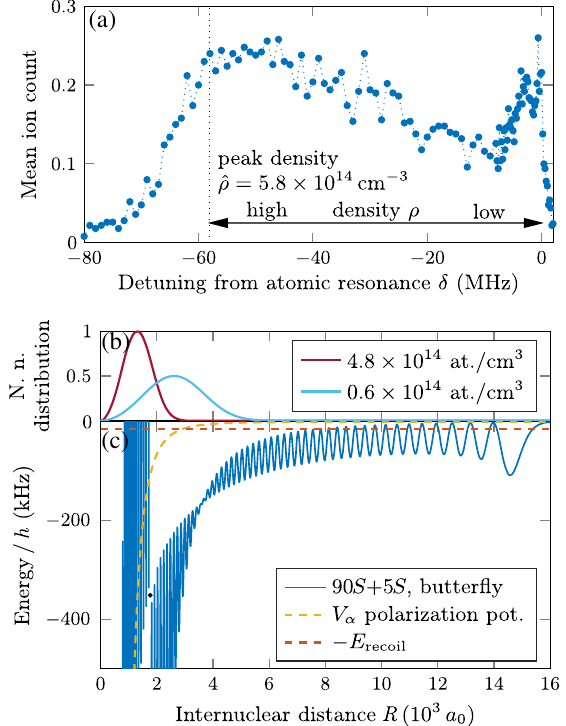
FIG. 2. (a) Spectrum of a 90 S Rydberg atom in a BEC. One of the excitation lasers is focused on the center of the BEC with a focal waist of 2 . 1 μ m. Therefore, primarily, the peak density ˆ ρ ¼ 5 . 8 × 10 14 cm − 3 of the BEC is addressed with a detuning of approximately − 58 MHz. Each data point is taken with 10 BECs, and each BEC is probed 50 times. During the subsequent experiments within one BEC, the peak density drops from 5 . 8 × 10 14 cm − 3 approximately 3 . 5 × 10 5 atoms of the initial 1 . 7 × 10 6 of the BEC are in the thermal cloud at the end of the experiment. The thermal atoms surrounding the BEC contribute to the signal at very small red detuning. The laser detuning is related to the local density where the Rydberg atom is excited [43]. (b) Nearest-neighbor distri- bution of the distance between the Rydberg core ( R ¼ 0 a 0 ) and a neutral atom for two different densities of the BEC. (c) On the same horizontal axis, the pair potential of a 90 S þ 5 S state, including the Rydberg electron-neutral scattering interaction and the Rydberg core-neutral polarization potential V α , is shown. The state crossing visible at 1700 a 0 (black dot) corresponds to a crossing of the butterfly state [10] and the 90 S þ 5 S state [see also Fig. 4(a)]. The highest energy available in the system comes ¼ h × 15 kHz, and therefore, most from the photon recoil, E rec of the particles inside the Rydberg orbit are classically